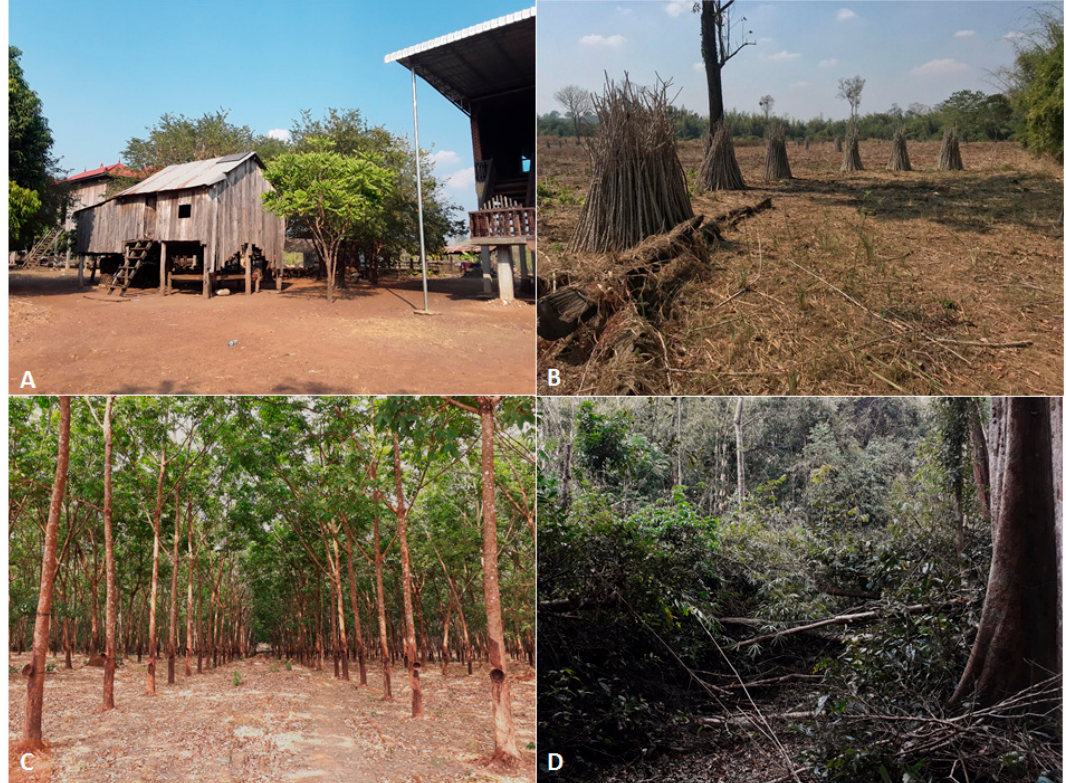
Figure 2. Example of the main environments within the study area. ( A ) Built-up area in a village. ( B ) Field used for cassava culture photographed after the collection of cassava plants. ( C ) Rubber tree plantation. ( D ) Primary forest.